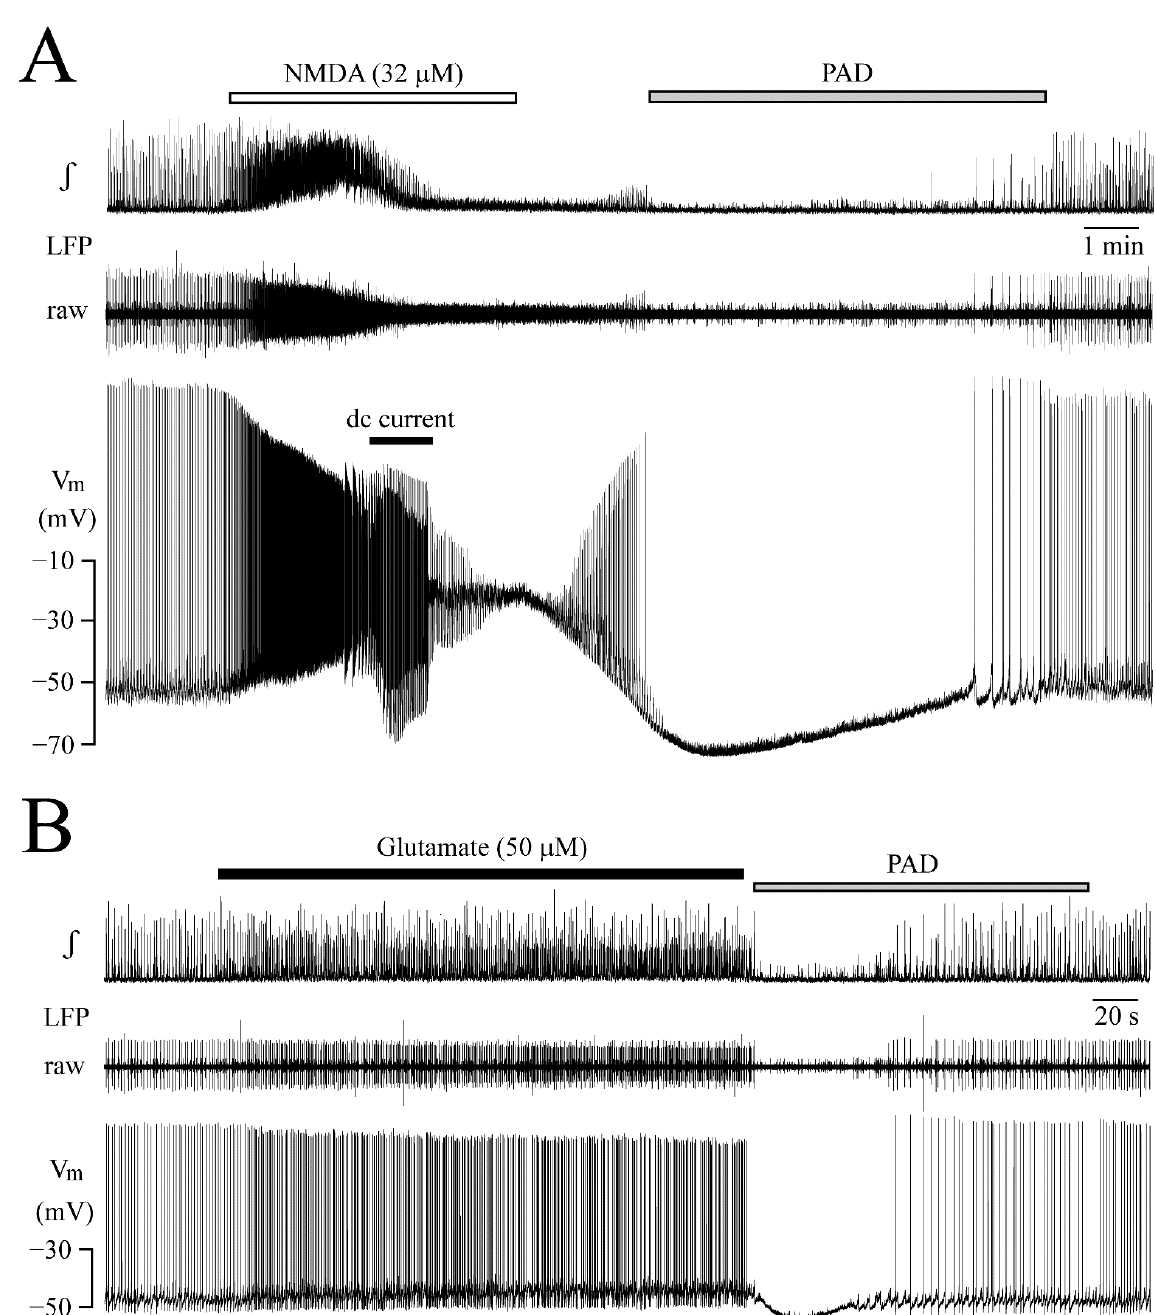
four different neurons, glutamate had depolarized V m at the start of PAD from − 48.5 ± 3 from − 48.5 ± 3 mV by 5.2 ± 3.2 mV ( p = 0.04), the maximal hyperpolarization was to mV by 5.2 ± 3.2 mV ( p = 0.04), the maximal hyperpolarization was to − 52.0 ± 1.6 mV ( p = − 52.0 ± 1.6 mV ( p = 0.03) and the effect was reversed after 1.5 ± 0.4 min. 0.03) and the effect was reversed after 1.5 ± 0.4 min.